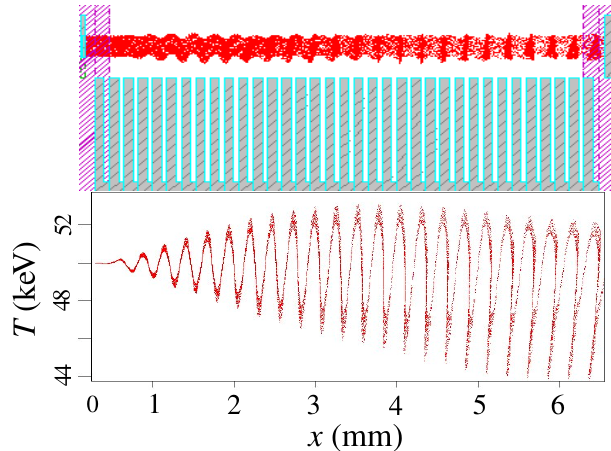
FIG. 5. (Color) Section of beam above grating (upper), and T - x phase-space distribution (lower) (Dartmouth).